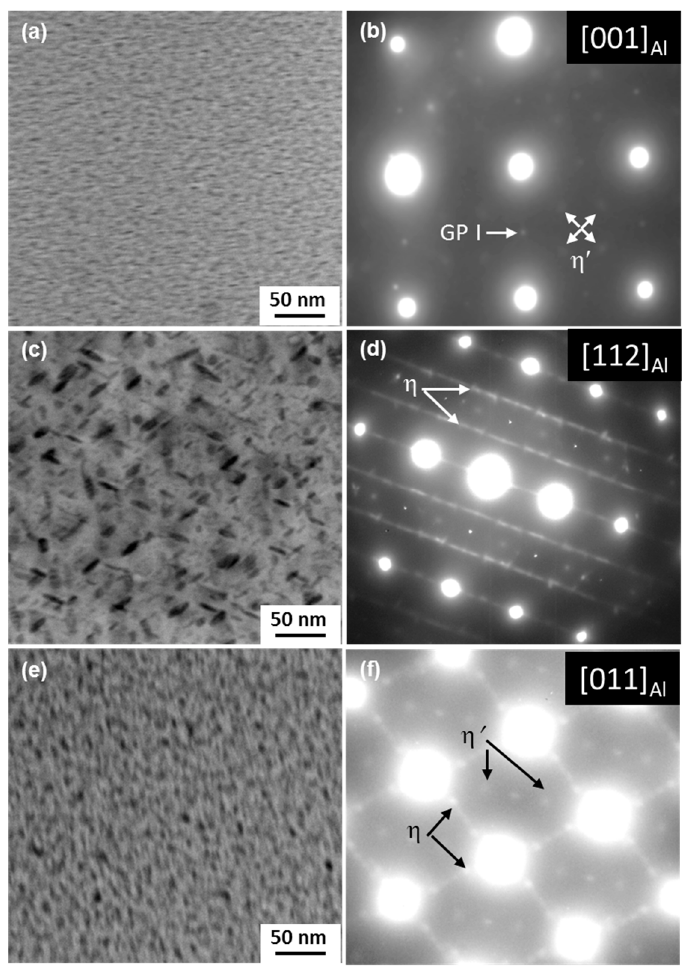
Figure 9. Intragrain precipitates and selected area electron diffraction (SAED) of the Ce-containing alloy at various aging tempers : ( a , b ) T6; ( c , d ) T7; ( e , f ) RRA.